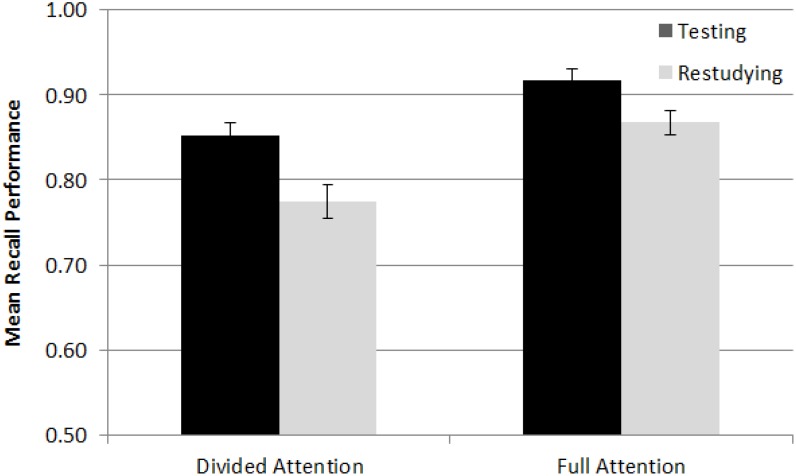
Mean recall performance in the testing and restudying condition of the full and divided attention conditions in Experiment 1. The cell means were averaged across retention intervals (immediate and delayed) and across item types (interesting and boring facts). Error bars indicate the standard errors of means.